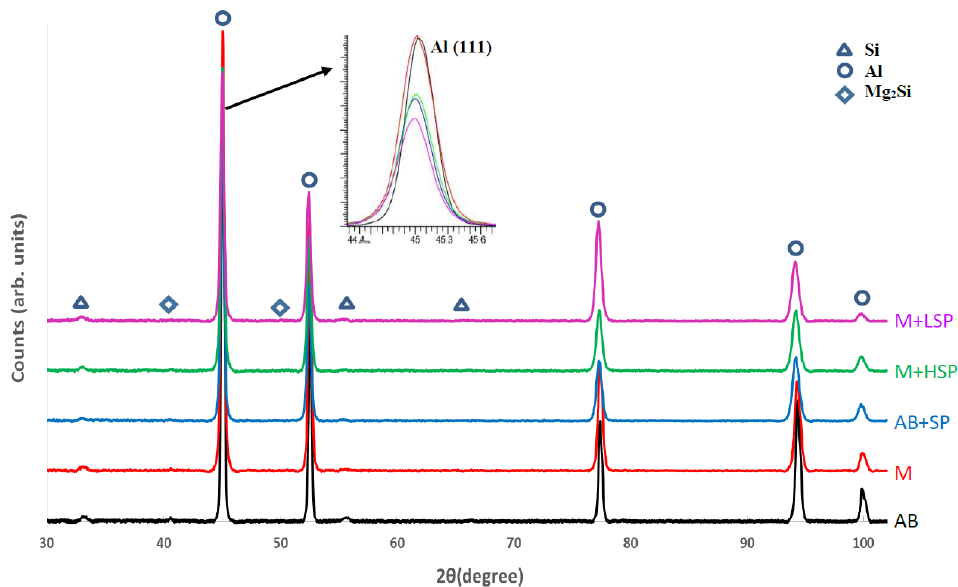
Figure 9. The X-ray diffraction (XRD) phase pattern of the AlSi10Mg samples under different SP conditions. Table 4. The average full width at the half maximum (FWHM) of Al and Si peaks of the as-built, rough-machined, and SP samples.